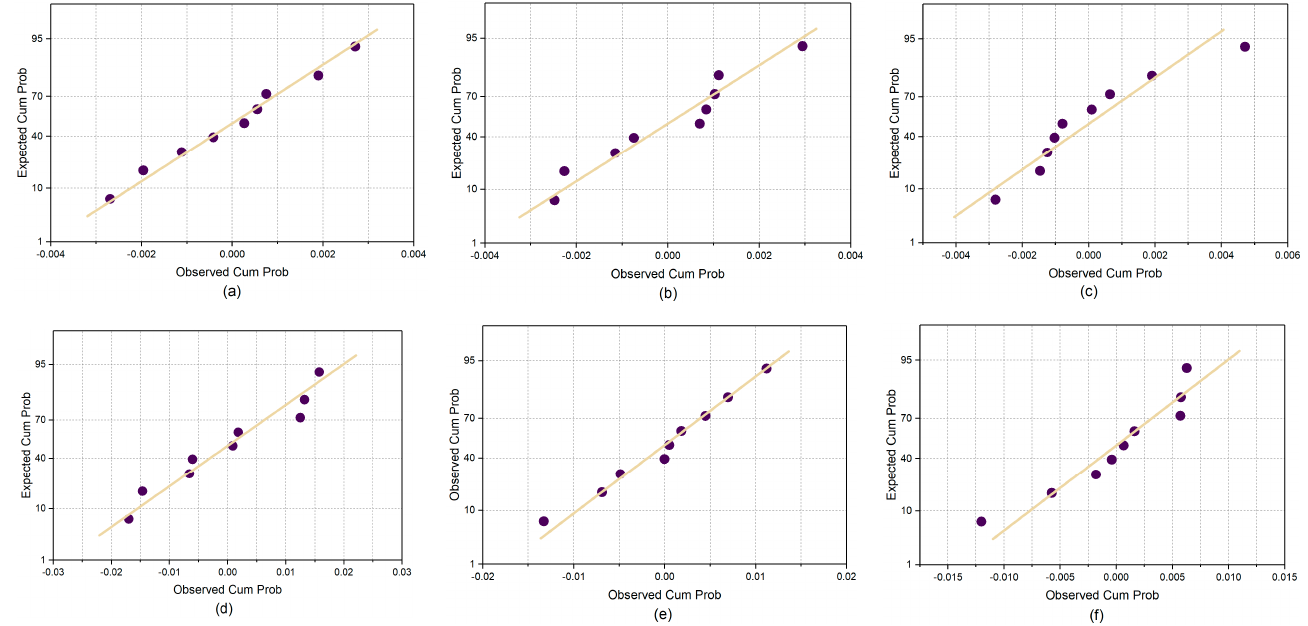
Figure 11. P − P plot of regression standardized residuals: ( a ) FVC (forests)-temperature; ( b ) FVC (forests)-rainfall; ( c ) FVC (forests)-daytime; ( d ) FVC (shrubs)-temperature; ( e ) FVC (shrubs)-rainfall; and ( f ) FVC (shrubs)-daytime.